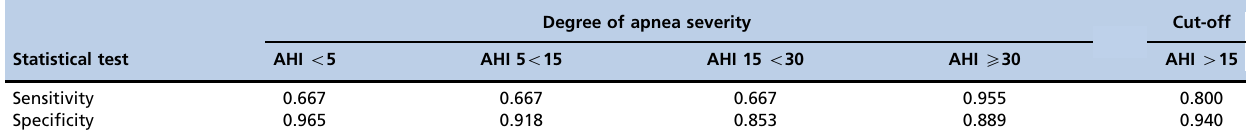
Table 3 - Sensitivity and specificity values of oxyhemoglobin desaturation index (ODI) to distinguish between patients with various degrees of apnea severity, i.e. , patients with mild or no apnea and patients with moderate or severe apnea. Degree of apnea severity